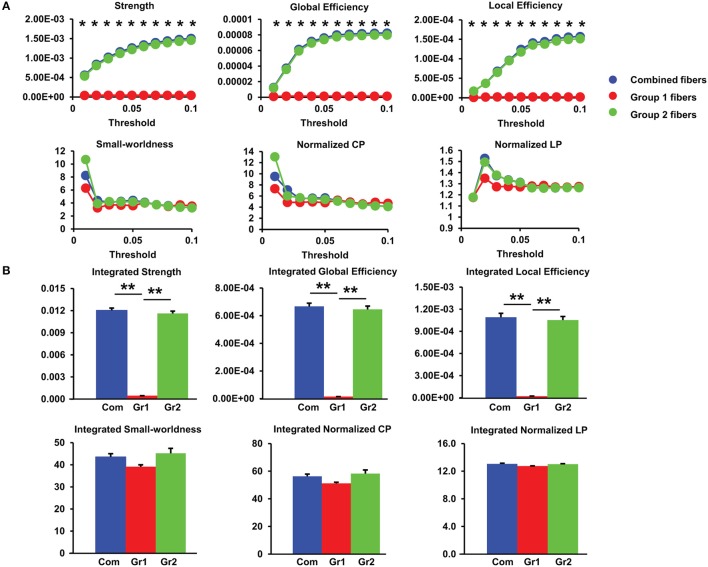
(A) Group differences in network measures among group1, group2, and combined fibers under different sparsity thresholds for 20 PMW fetal brain structural connectome. Asterisks: significant group differences with non-parametic ANOVA at p < 0.05/10 (Bonferroni-corrected). (B) Differences in integrated global network measures contributed by three groups of fibers. **p < 0.01. The error bars indicate standard deviation. Com: combined group1 and group2 fibers; Gr1: group1 fibers; Gr2: group2 fibers.